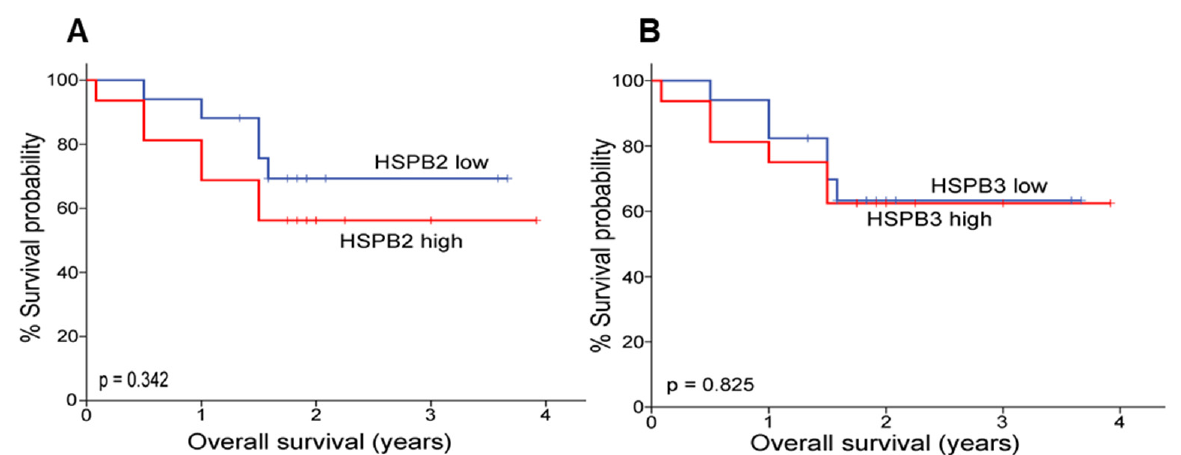
Figure 5. Kaplan–Meier survival curves for the overall survival (OS) of MIBC (T2–T4) patients according to HSPB2 ( A ) and HSPB3 ( B ) mRNA expression levels. p -value was calculated using the log-rank